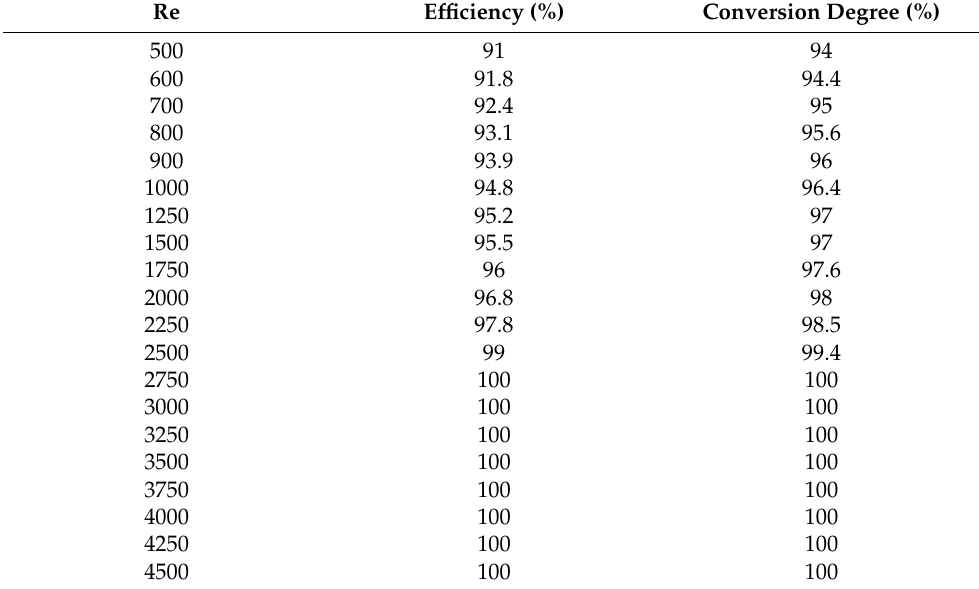
Table 3. Efficiency and conversion